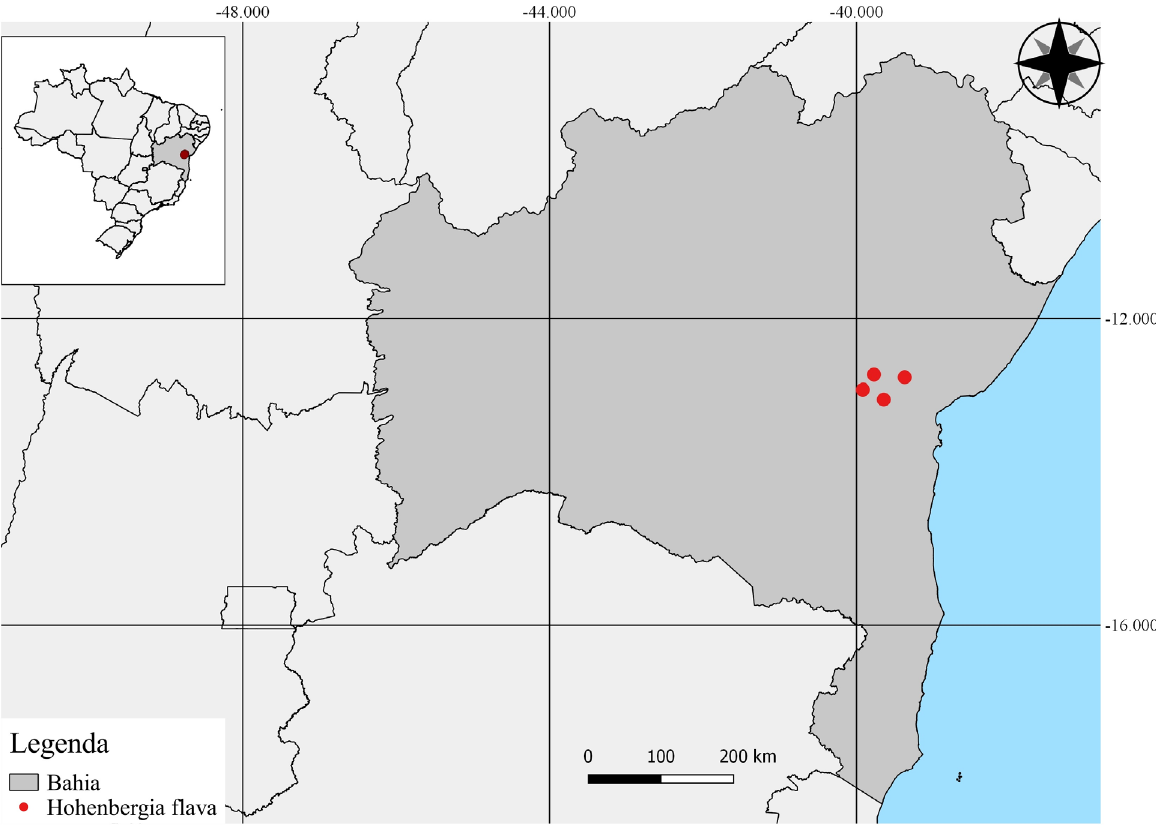
Figure 3. Geographic distribution of Hohenbergia lanata Pereira & Moutinho emend. B.P. Cavalcante, E.H. Souza, A.P. Martinelli & L.M. Versieux in the state of